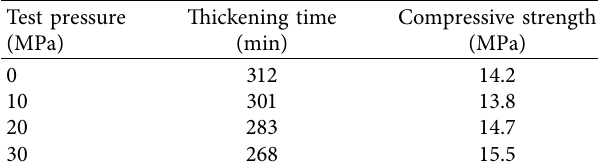
Table 13: Pressure and cement slurry performance.